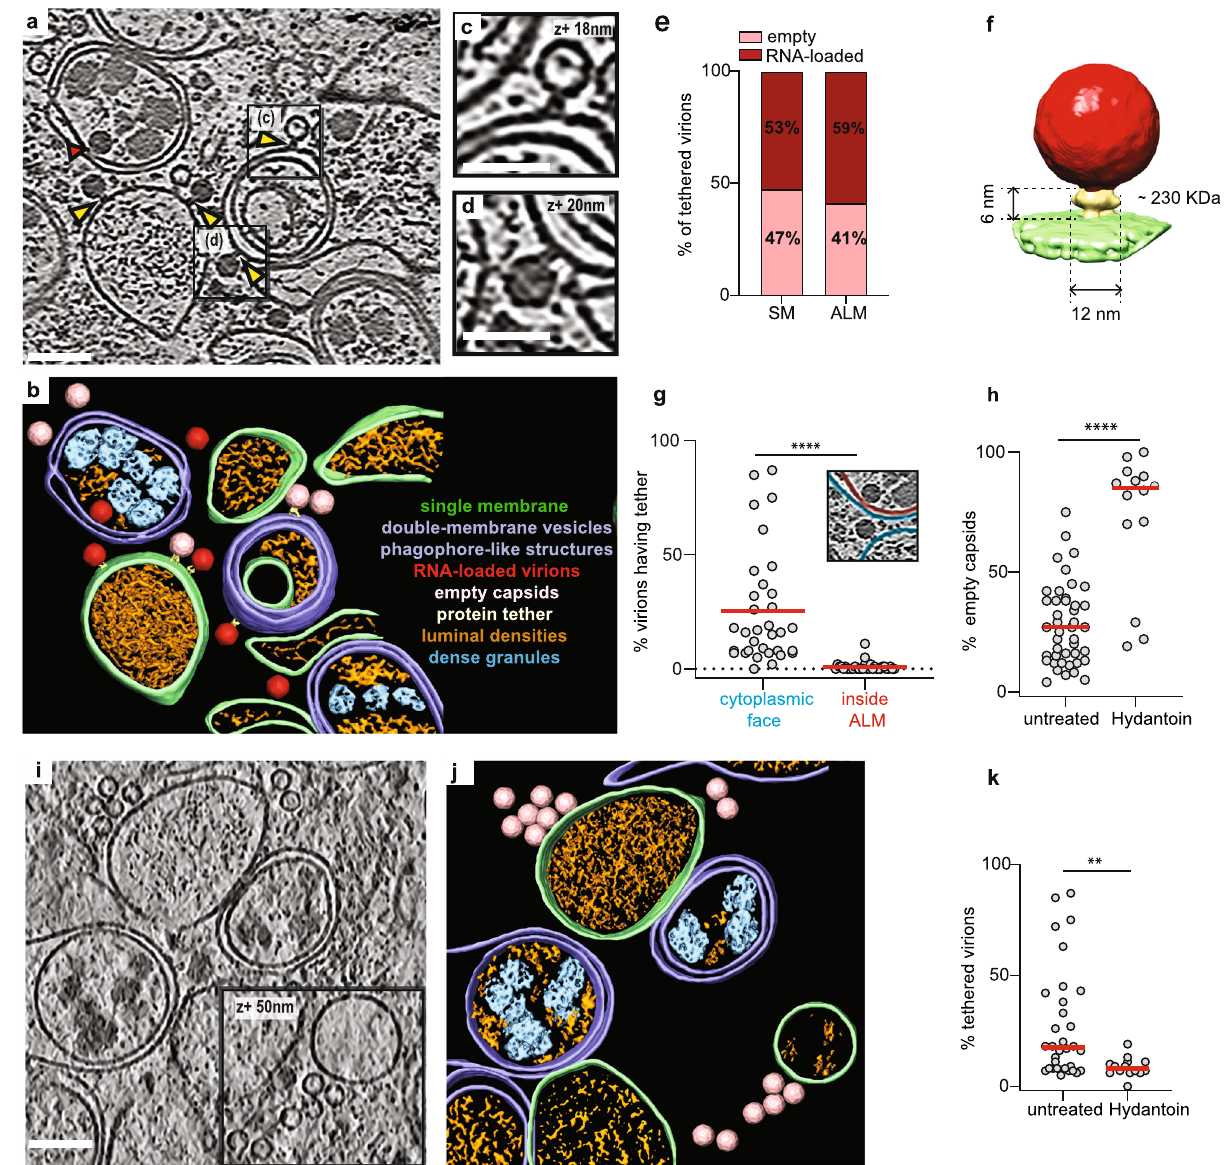
g Percentage of ( n ) virions observed on the outside ( n =520, blue) and inside ( n =22, red) of ALM having avisible tether to amembrane asindicated inthe inset. h Percentage of empty capsids observed in ( n ) tomograms of untreated ( n =43) and Hydantoin-treated cells ( n =14) at 6h p.i., as measured by template matching. Horizontallines represent the average. i Cryo-electron tomogramof a PV-infected, Hydantoin-treated cell at 6h p.i., containing several empty capsids which are not tethered to the surrounding membranes. j Segmentation of the tomogram in ( i ). Color labels for each structure are the same in ( b ) and empty capsids are repre- sented by their subtomogram average. k Percentage of tethered virions as observed in ( n ) cryo-tomograms of untreated ( n =33) and Hydantoin-treated ( n =14)cellsat6hp.i.Horizontallinesrepresenttheaverage.Inallgraphs,eachdot corresponds to one tomogram analyzed (see also Supplementary Table 2). Statis- tical signi fi cance by unpaired two-tailed Student ’ s t test: g **** p <0.0001, h ** p =0.0138, k ** p =0.0089. Scale bars: a – i 100nm, c , d